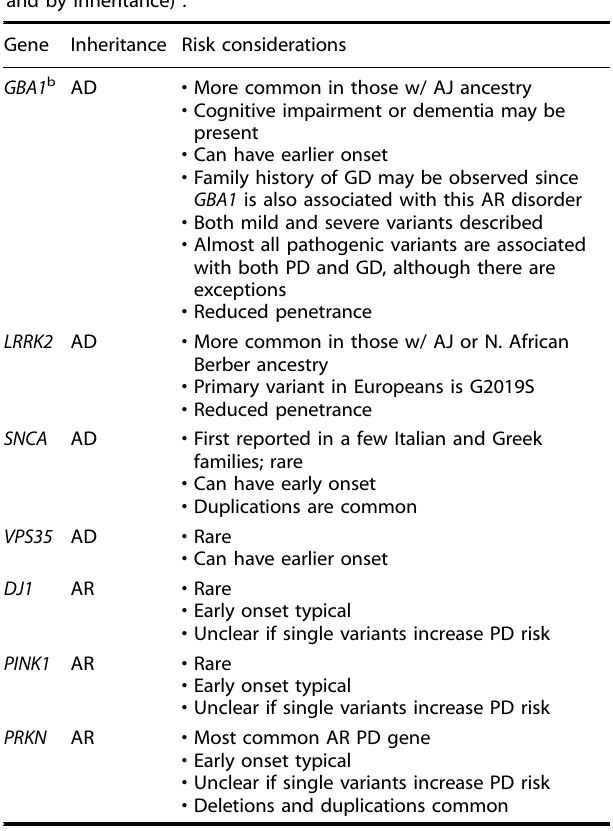
Table 3. Established monogenic PD genes (ordered alphabetically and by inheritance) a .